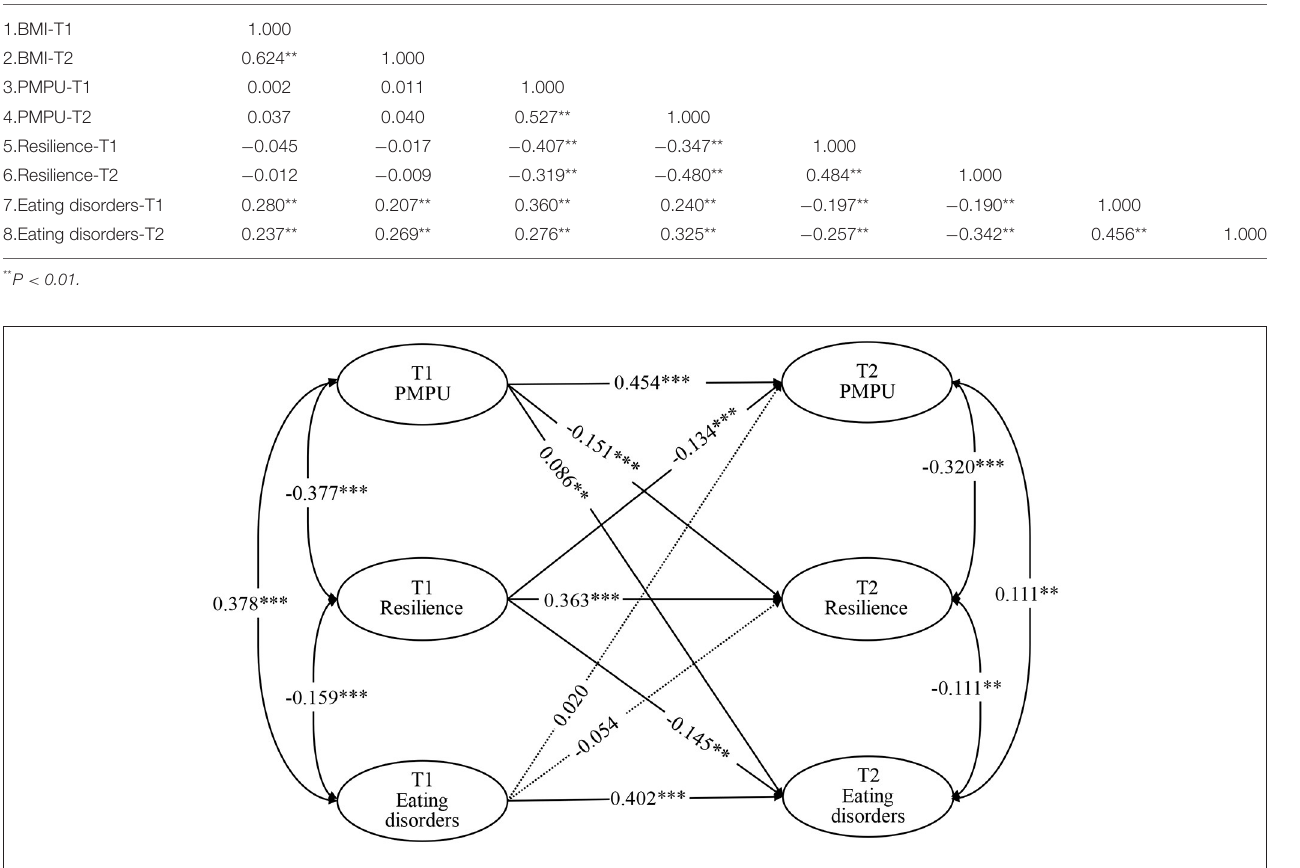
TABLE 2 | Spearman correlations analyses for BMI, PMPU, resilience, and eating disorders at two time points. Variables